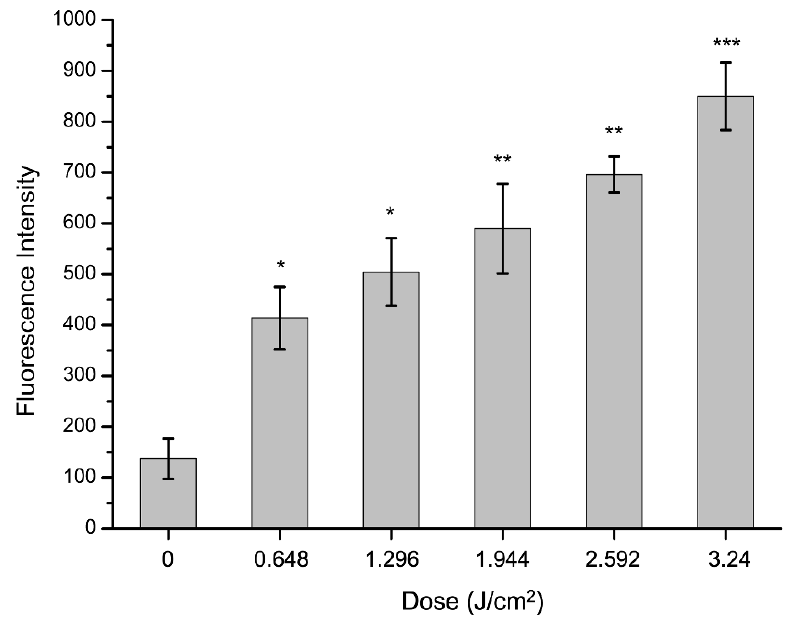
Figure 6. Intracellular ROS of S. aureus after aPDT for different light dose (0, 0.648, 1.296, 1.944, 2.592, 3.24 J/cm 2 ). Bars with asterisks indicate significant difference ( p < 0.05) compared to the control group. The more asterisks, the stronger the